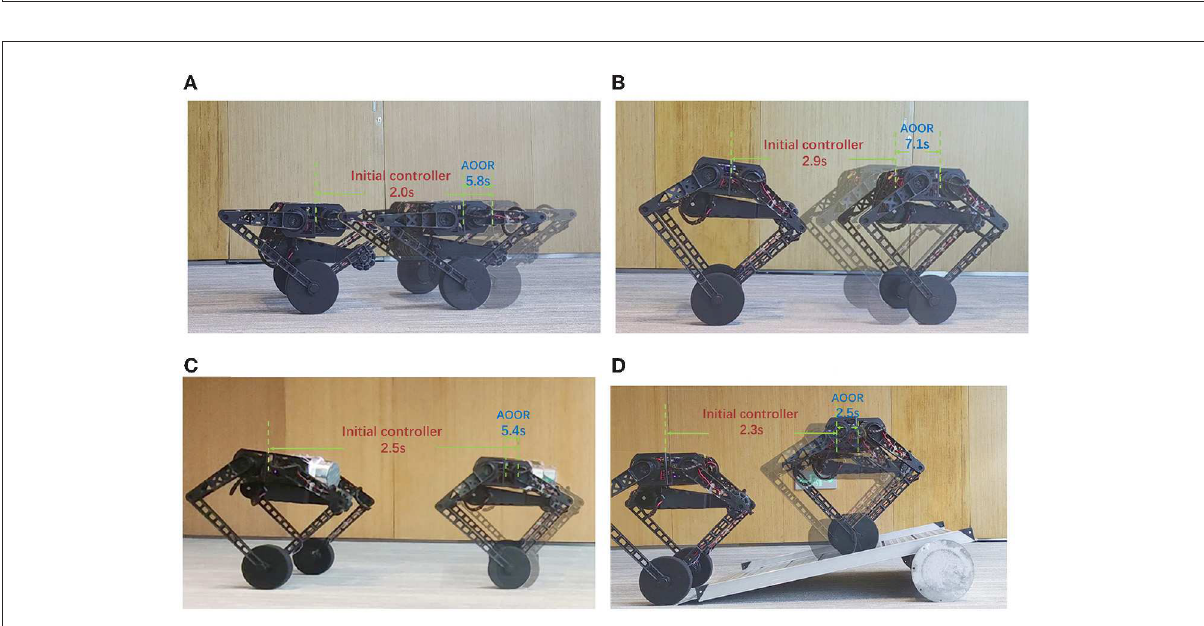
FIGURE9 Still images during the testing. Many more maneuvers in action and experimental data are shown in the accompanying video. (A) Height = 0.33 m, (B) height = 0.5 m, (C) height = 0.5 m with the load, (D) height = 0.5 m on the slope.